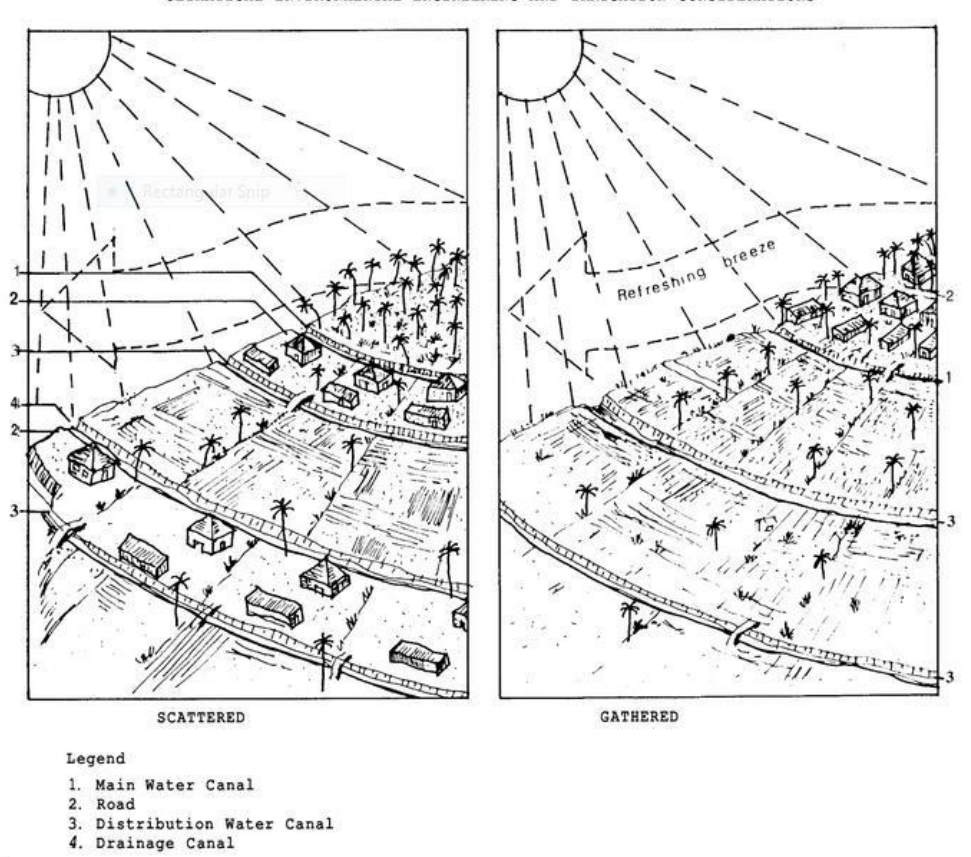
Figure 2. Schematic representation of the surface irrigation system design used by the Mahaweli Development Project [21] .